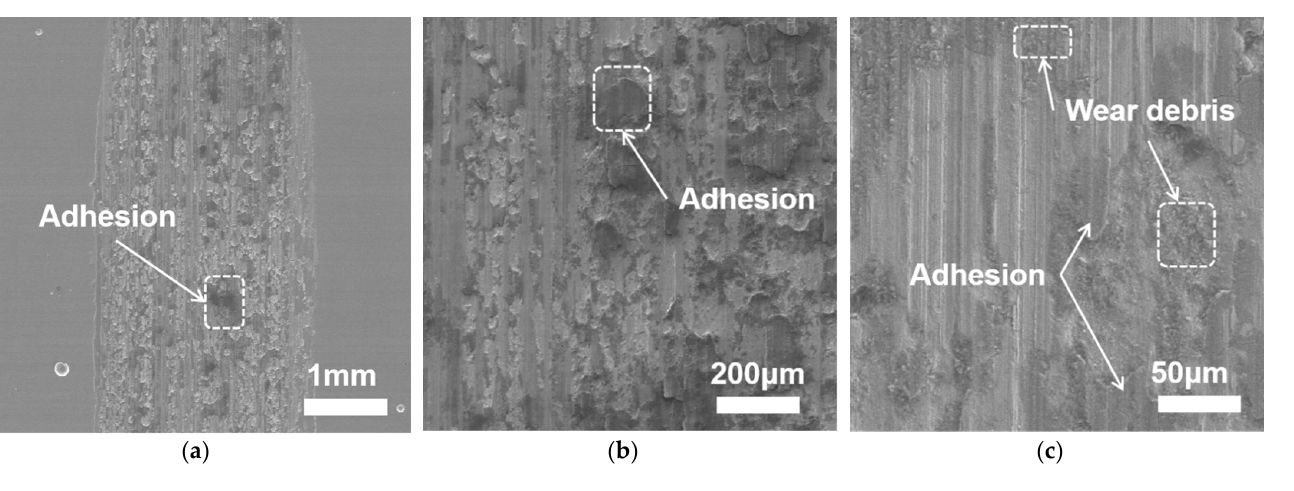
Figure 6. Ni-based alloy coating SEM images. These three images are obtained under different microscopic multiples of the same area. ( a ) Wear marks of Ni-based coating at 1mm of the scale; ( b ) Wear marks of Ni-based coating at 200 µ m of the scale; ( c ) Wear marks of Ni-based coating at 50 µ m of the scale.